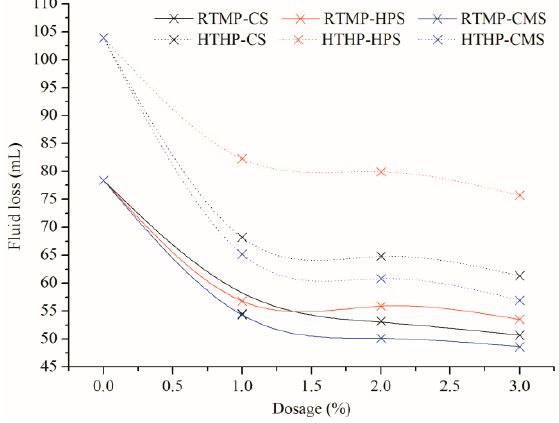
Figure 2. The static fluid loss of control and AAC with different dosage of CS, HPS and CMS.